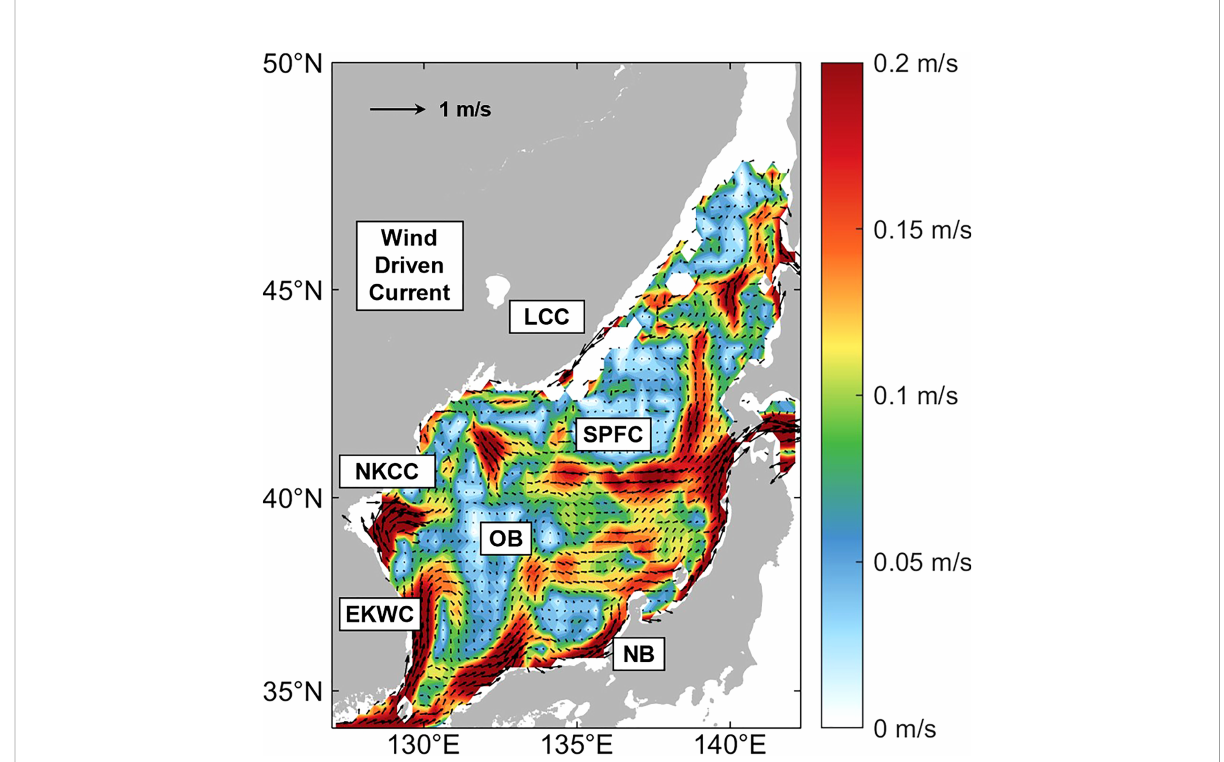
FIGURE 7 The climatological ocean circulation patterns at 15 m depth as represented by the Drifter interpolation dataset with the major fl ows labeled by white boxes. EKWC, East Korea Warm Current; NKCC, North Korea Cold Current; NB, Nearshore Branch; OB, Offshore Branch; SPFC, SubPolar Front Current; LCC, Liman Cold